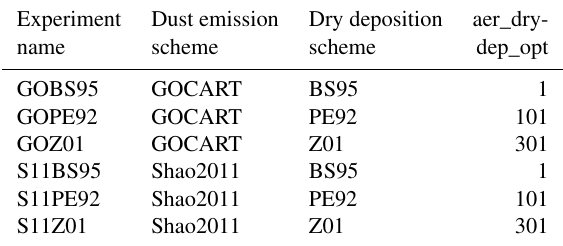
Table 3. Model experiments and the corresponding model configu- ration in